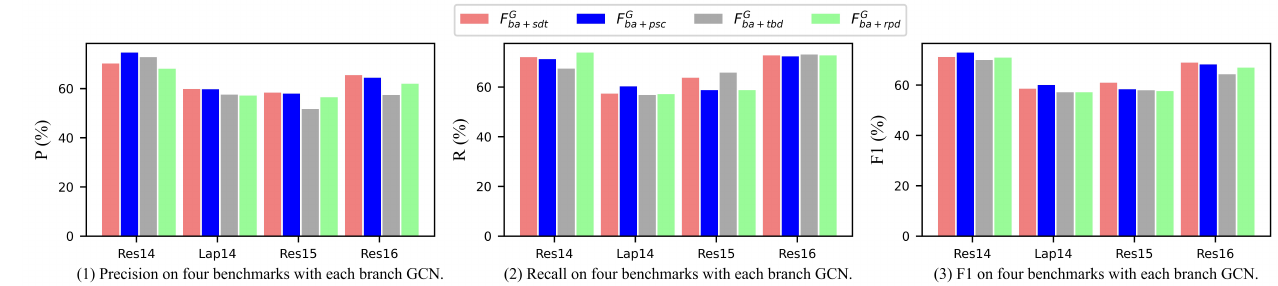
Figure 6. The Results of Ablation Study on V 2 . Res14 means Restaurant14, Lap14 means Laptop14, Res15 denotes Restaurant15, and Res16 denotes